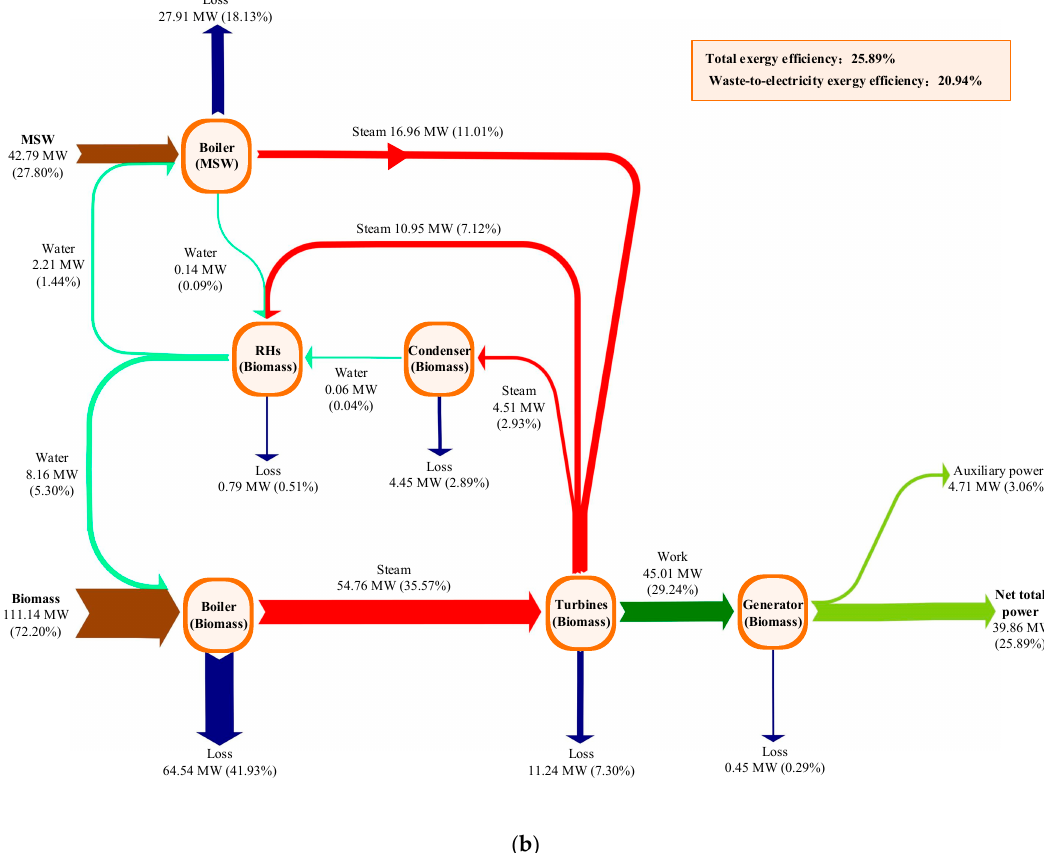
Figure 5. Exergy flows of the two schemes. ( a ) Separate scheme. ( b ) Integrated scheme.